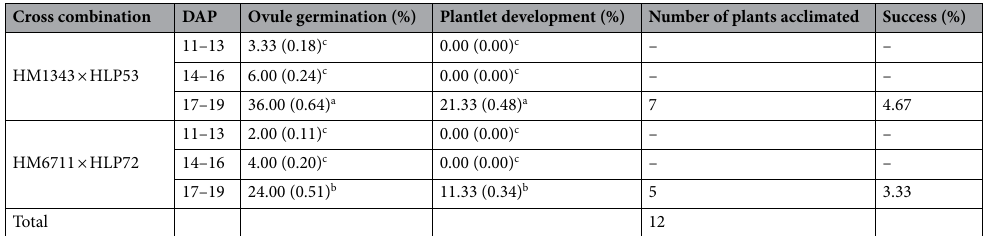
Table 2. Interspecific hybridization between C. moschata × C. pepo through ovule culture. DAP: days after pollination. Mean values with different letters in column are significantly different at P ≤ 0.05 according to Tukey’s HSD (Honest Significant Difference) test. Figures in parentheses are the means of arcsine transformed values.